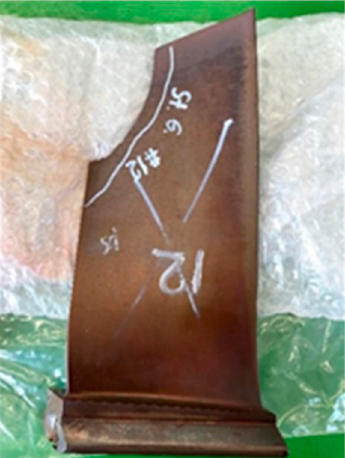
Figure 1. An example of compressor blade fracture.